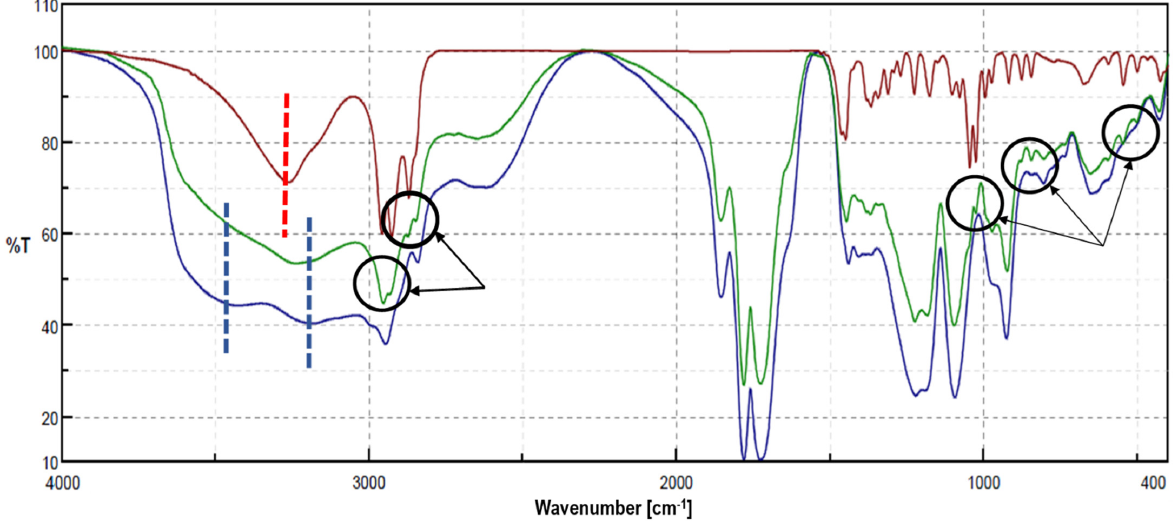
Figure 2. Fourier transform infrared spectroscopy (FTIR) spectra of menthol (red line), F 139 s (blue line), and menthol-loaded F 139 s (green line) in KBr pellets. Evidence of the encapsulated menthol, including the new IR bands, is indicated in circles.